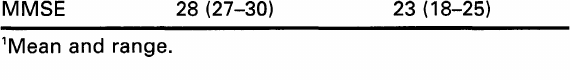
TABLE I. Demographic details Age NART IQ MMSE 'Mean and